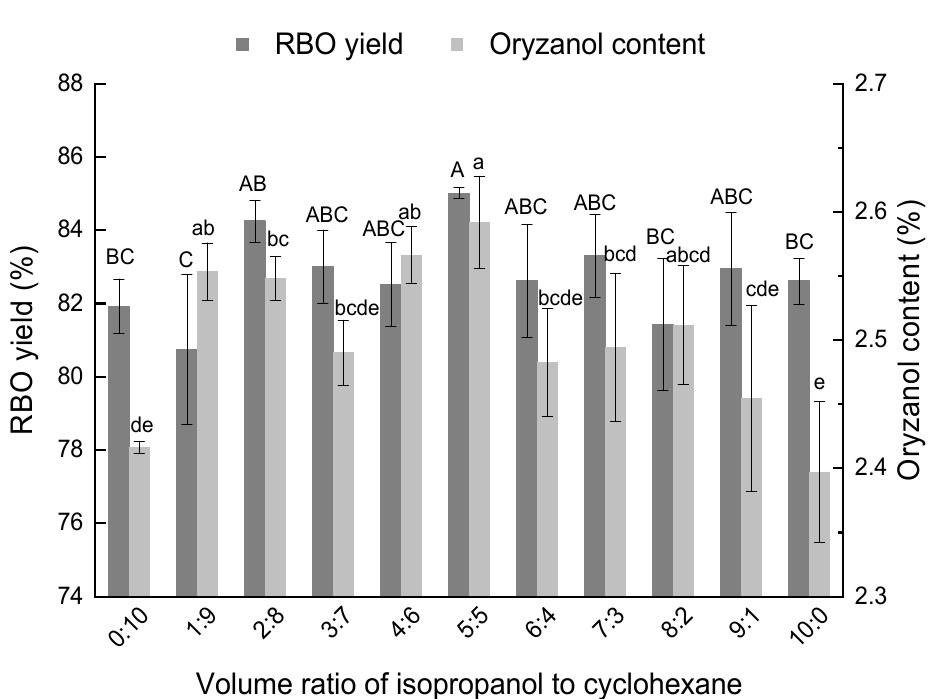
Figure 2. Effect of mixing ratio on RBO yield. Different uppercase and lowercase above the columns indicate significant differences in RBO yield and oryzanol content ( p < 0.05).